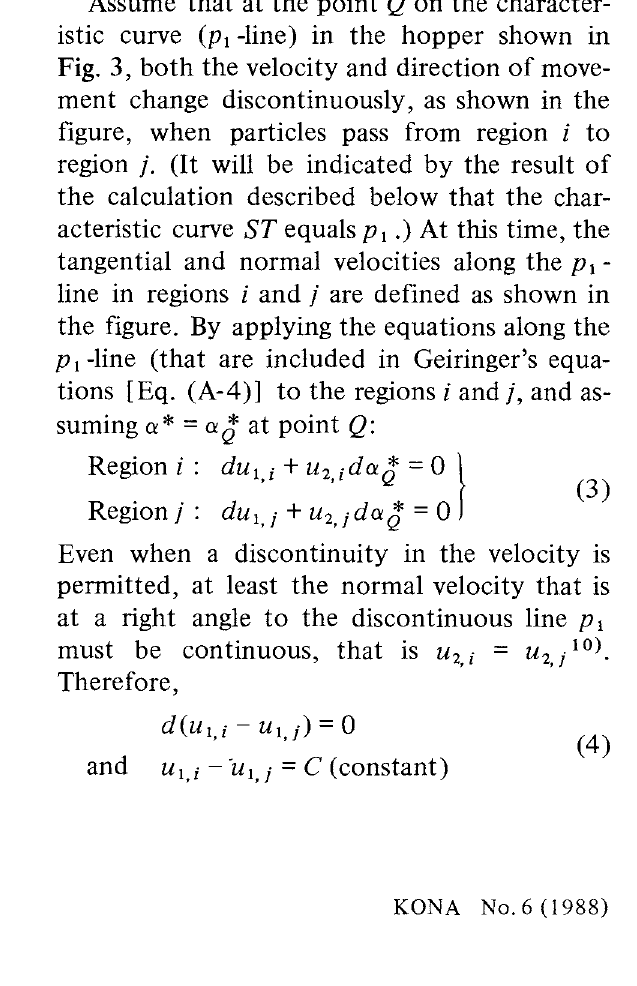
Fig. 5 Distribution of the position of discontjnuity in Uz and network of velocity characteristics